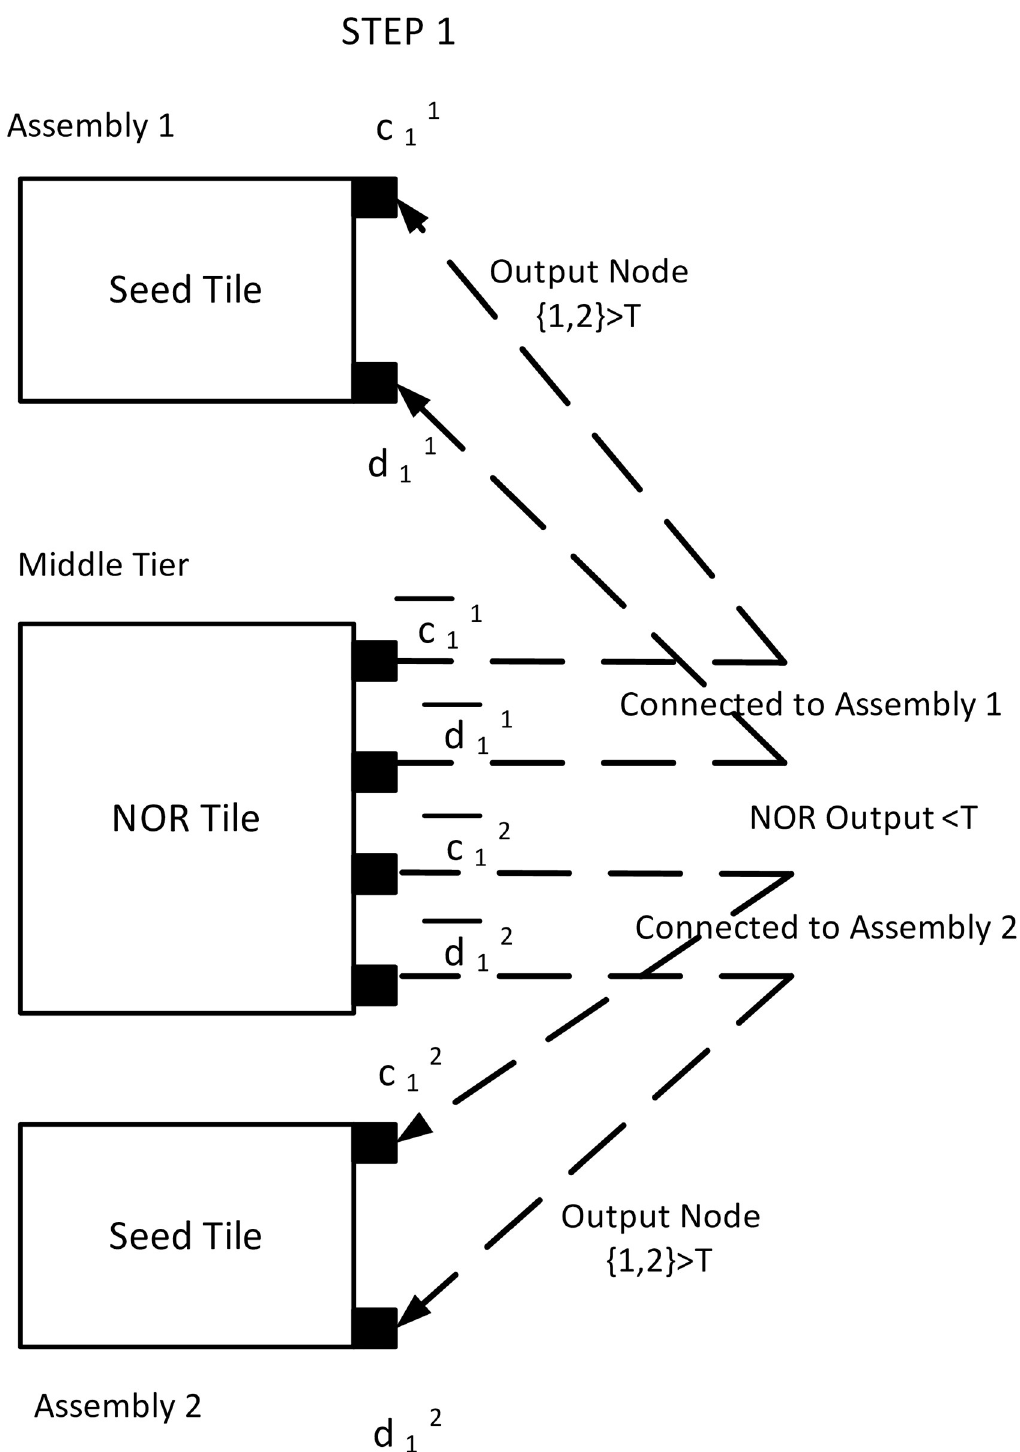
Fig 9. Step 1 of the example assembly. Fig. shows the step 1 for an example case with two seed tiles. Both of the assemblies have > t . A NOR tile will attach to both of them and the NOR output is < τ . V A ð 1 ; 2 Þ